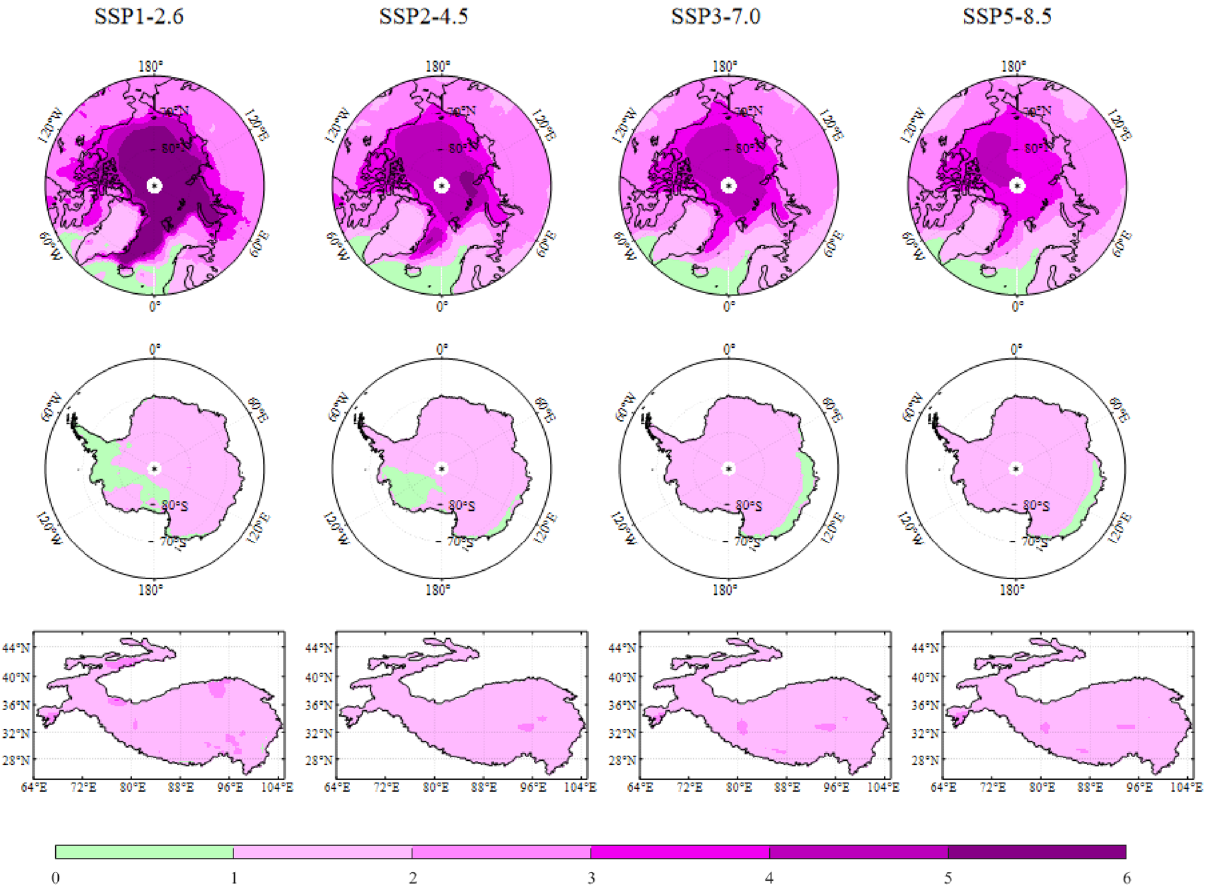
Figure 10. Similar to Fig. 9, but for the PAI2 that eliminating Earth’s three poles. The map was drawn in the software MATLAB R2018b (https:// ww2. mathw orks. cn/ produ cts/ matlab.